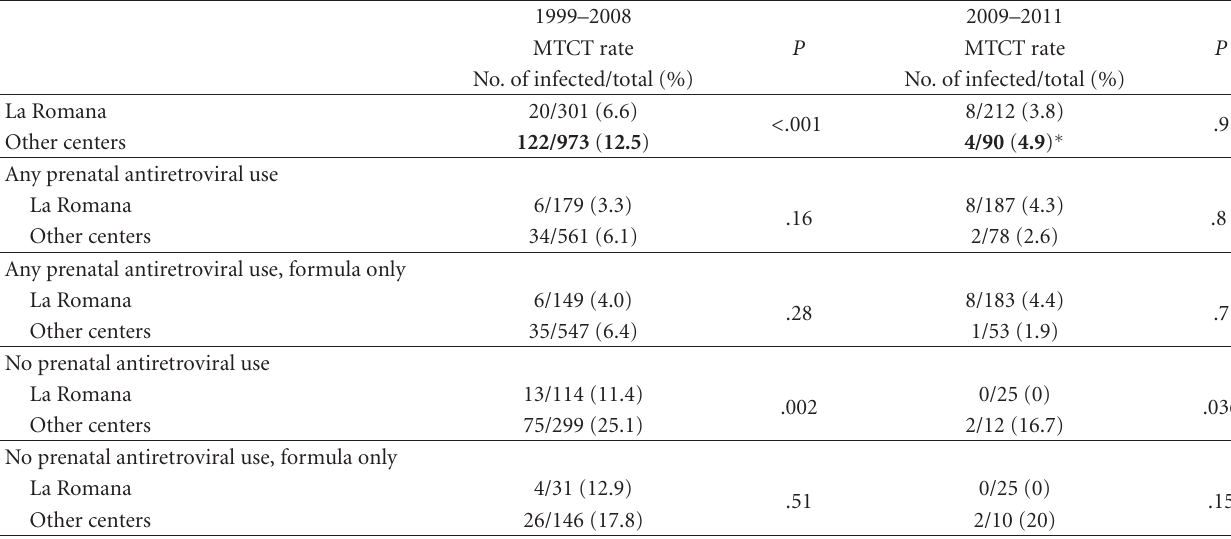
Table 3: Mother to child transmission (MTCT) rates by period (before recommendation of highly active antiretroviral therapy (HAART) for prevention of MTCT (1999–2008), and after (2009–2011) by center (La Romana center versus others) and prevention strategies, Dominican